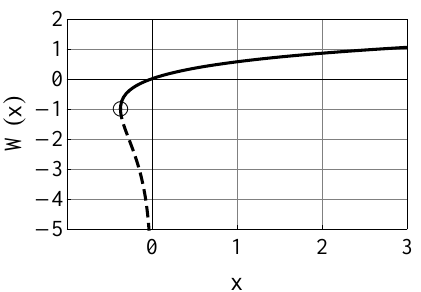
Figure 3. Variation of ξ = A 2 − ln η , shown here for A = 0 . 05 and 0 . 1 with full and dashed lines, re- spectively. The thin dashed line gives the gravitational exponential atmosphere without electron flow, i.e. A = 0.